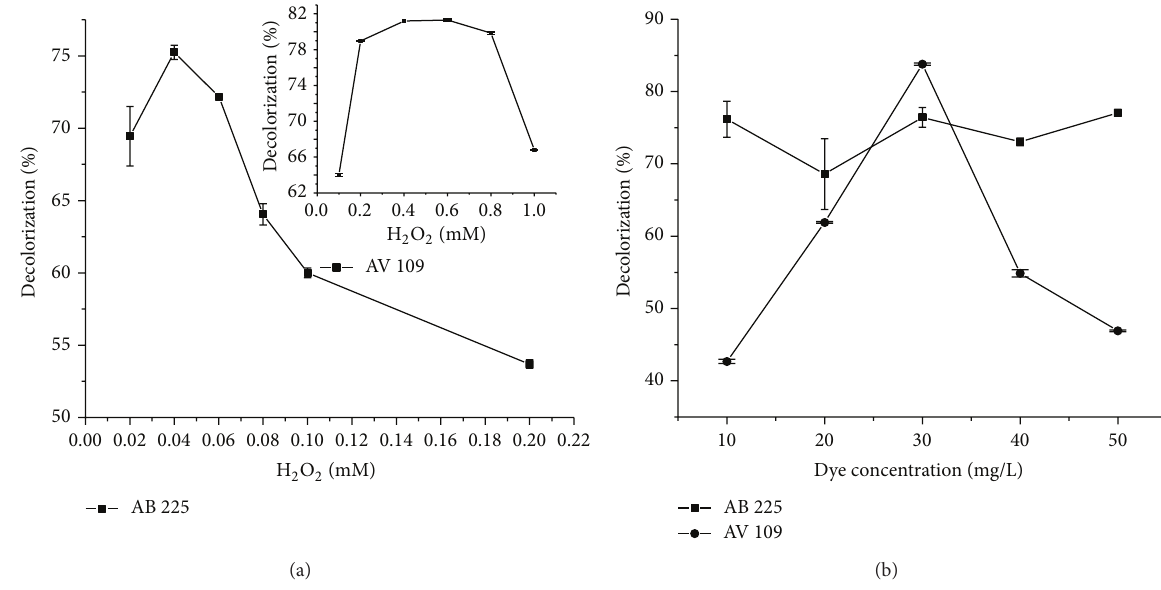
Figure 4: The decolorization percentage as a function of H 2 O 2 concentration (a) and dye concentration (b). Reaction conditions for AB 225: reaction time 32 minutes, enzyme concentration 0.15 IU/mL, pH 5.25, and temperature 24 ∘ C; for AV 109: reaction time 15 minutes, enzyme concentration 0.15 IU/mL, pH 5.5, and temperature 24 ∘ C.